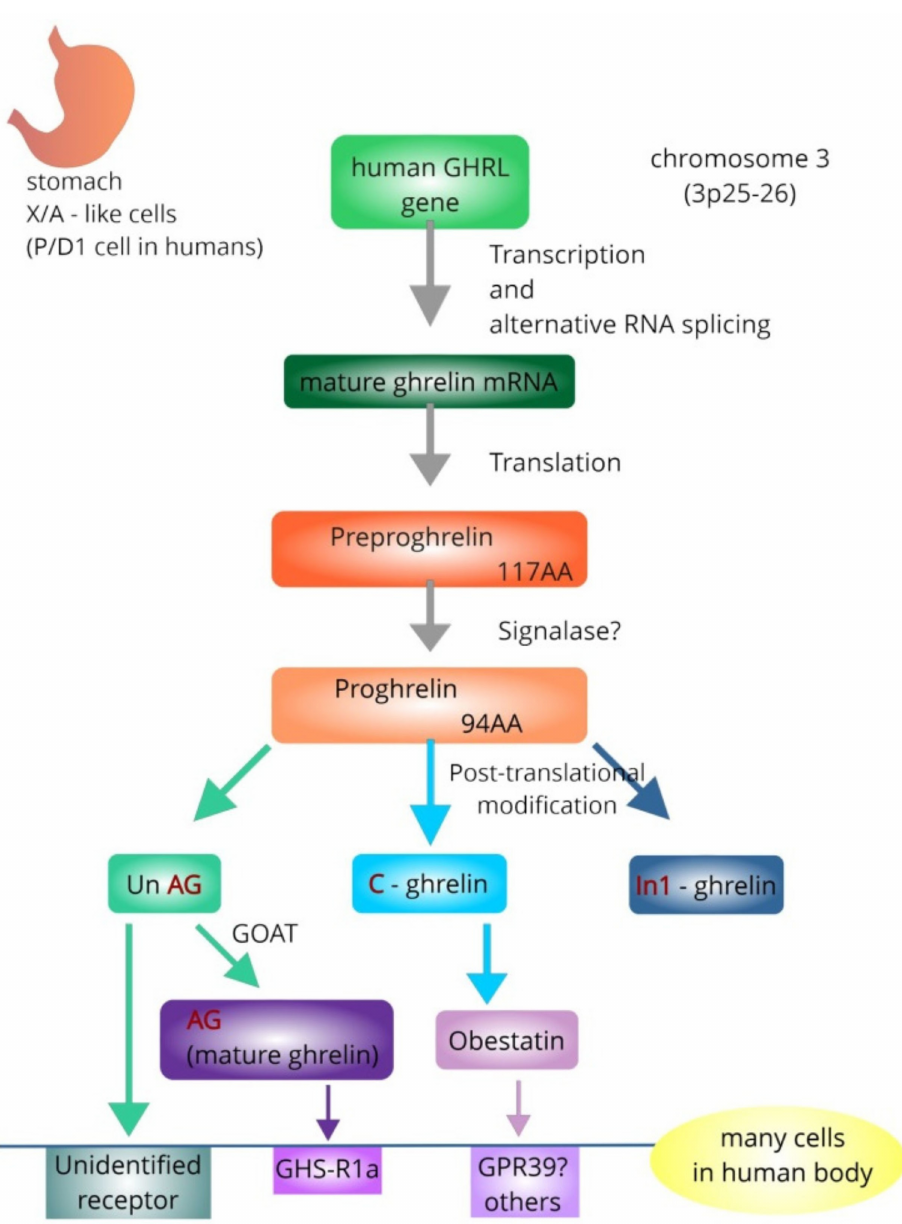
Figure 1. Simplified representation showing formation of mature, acylated ghrelin (AG) and obestatin from human ghrelin gene ( GHRL ). The GHRL contains six exons and four introns in total, and the introns enable alternative splicing [66]. The AG strongly binds growth hormone secretagogue receptor 1a (GHS-R1a), which is responsible for its GH-releasing capacity and the majority of its biological functions [21,63,73,74]. The proposed receptor for obestatin is GPR39, but other receptors are not excluded. The receptor for unacylated ghrelin (UnAG) is undetermined. [AA—amino